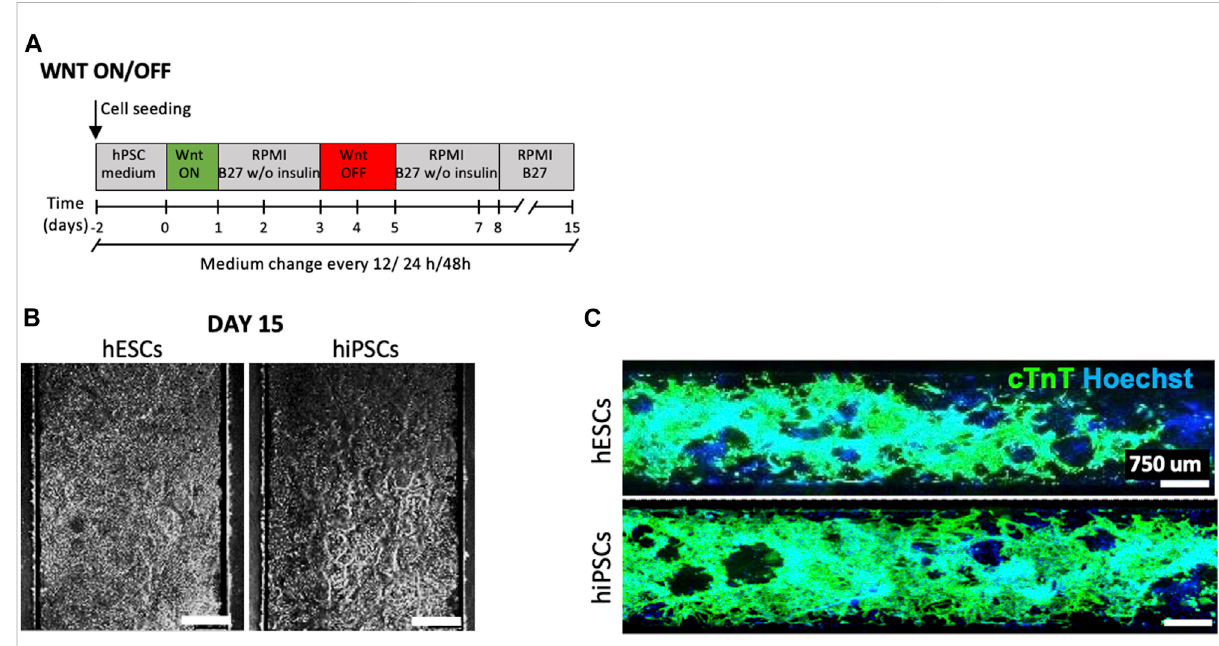
FIGURE 2 Cardiomyocytedifferentiationonchip. (A) SchematicrepresentationofthestandardprotocolbasedonbiphasicroleofWnt/ β -cateninsignaling (Lian X, 2012) adaptated and optimized into the micro fl uidic platform. The medium change has been performed every 12, 24, and 48 h. (B) Longitudinal section of a microchannel with CMs at day 15 of cardiac differentiation of hESCs and hiPSCs, medium change of 12 h and ECM 2.5%. Scale bars 450 μ m. (C) Immuno fl uorescence staining for cTNT (green) in CMs obtained from hESCs (upper panel) and hiPSCs (lower panel) differentiated after optimization of the standard protocol in micro fl uidics (medium change every 12 h). Nuclei were counterstained with Hoechst. Scale bars 750 μ